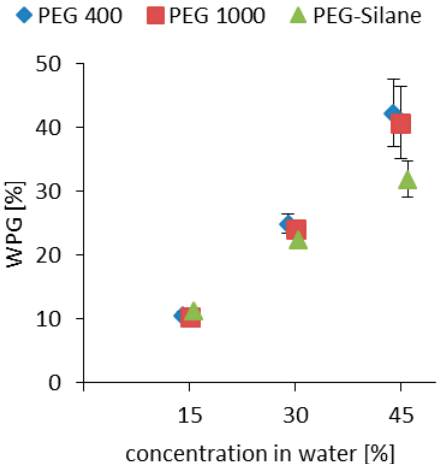
Figure 2. Weight percent gain (WPG) of impregnated oak wood achieved with different PEG impregnation agents and different concentrations of impregnation agent in water. Standard deviation given in whiskers. Different modification agent concentrations result in statistically significant different WPG.